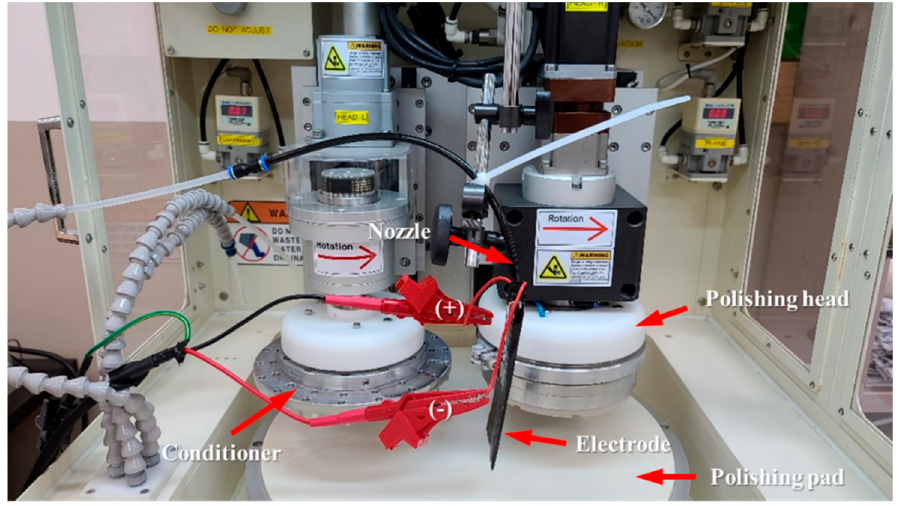
Figure 2. Electrolytically ionized CMP system (POLI-400, G&P Technology Inc.) for the experiment.